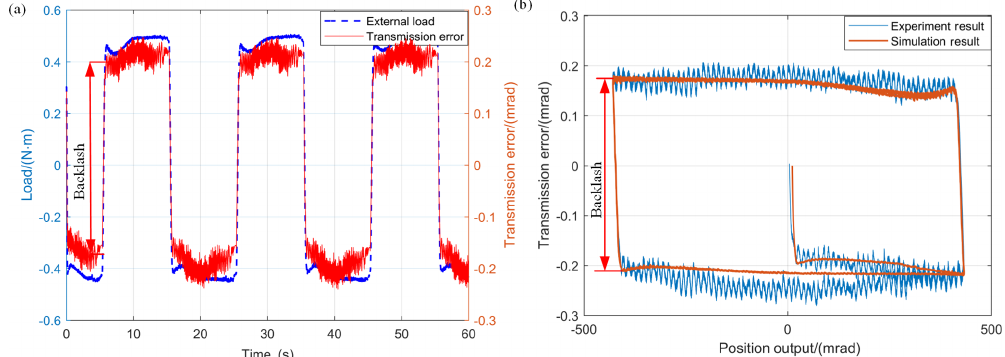
Figure 9. Test results for transmission backlash: (a) the time history of external load and transmission error; (b) comparison of experimental and simulation results of transmission